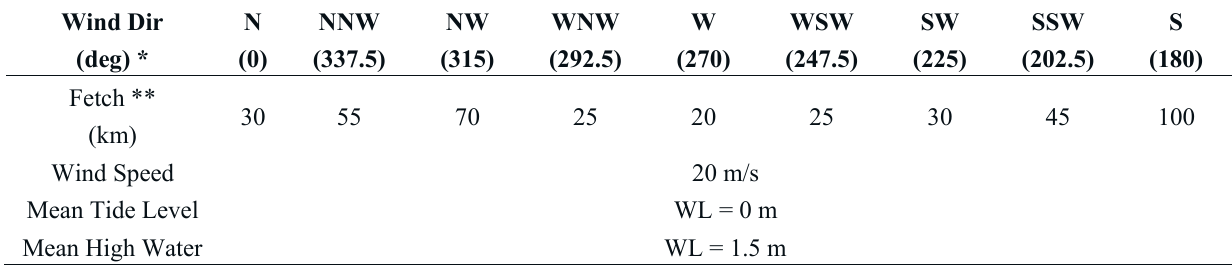
Table 2. Design wind and water level conditions for a 50-year return period northeaster storm. Wind